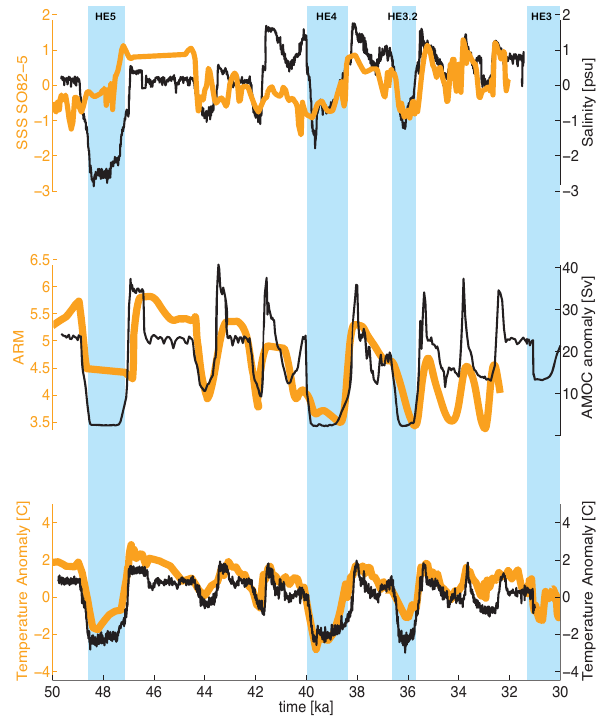
Fig. 8. From top to bottom: time series projected onto GICC05 age scale (Andersen et al., 2006; Svensson et al., 2006) of Nordic Seas salinity from core S082-5 (van Kreveld et al., 2000) and simulated surface salinity anomalies at this location; simulated maximum meridional overturning circulation in the North Atlantic (Sv) com- pared to North Atlantic marine sediment cores ARM data (Kissel et al., 2008); simulated SST anomalies off the Iberian margin (15– 8 ◦ W, 37–43 ◦ N) compared to alkenone-based SST anomalies from marine sediment core MD01-2444 (Martrat et al., 2007). Model re- sults are in black and paleoproxy records in